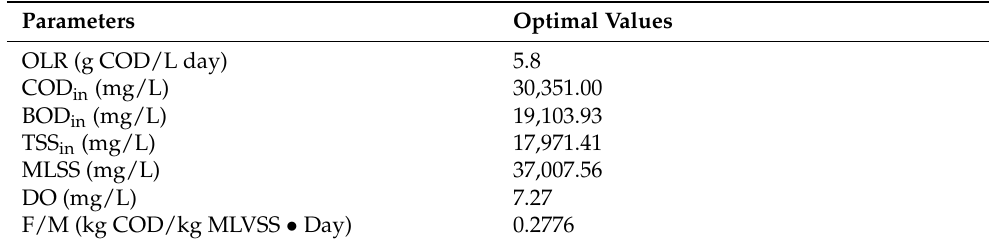
Table 6. Optimum operating condition for maximum COD removal (%) from aerobic process.